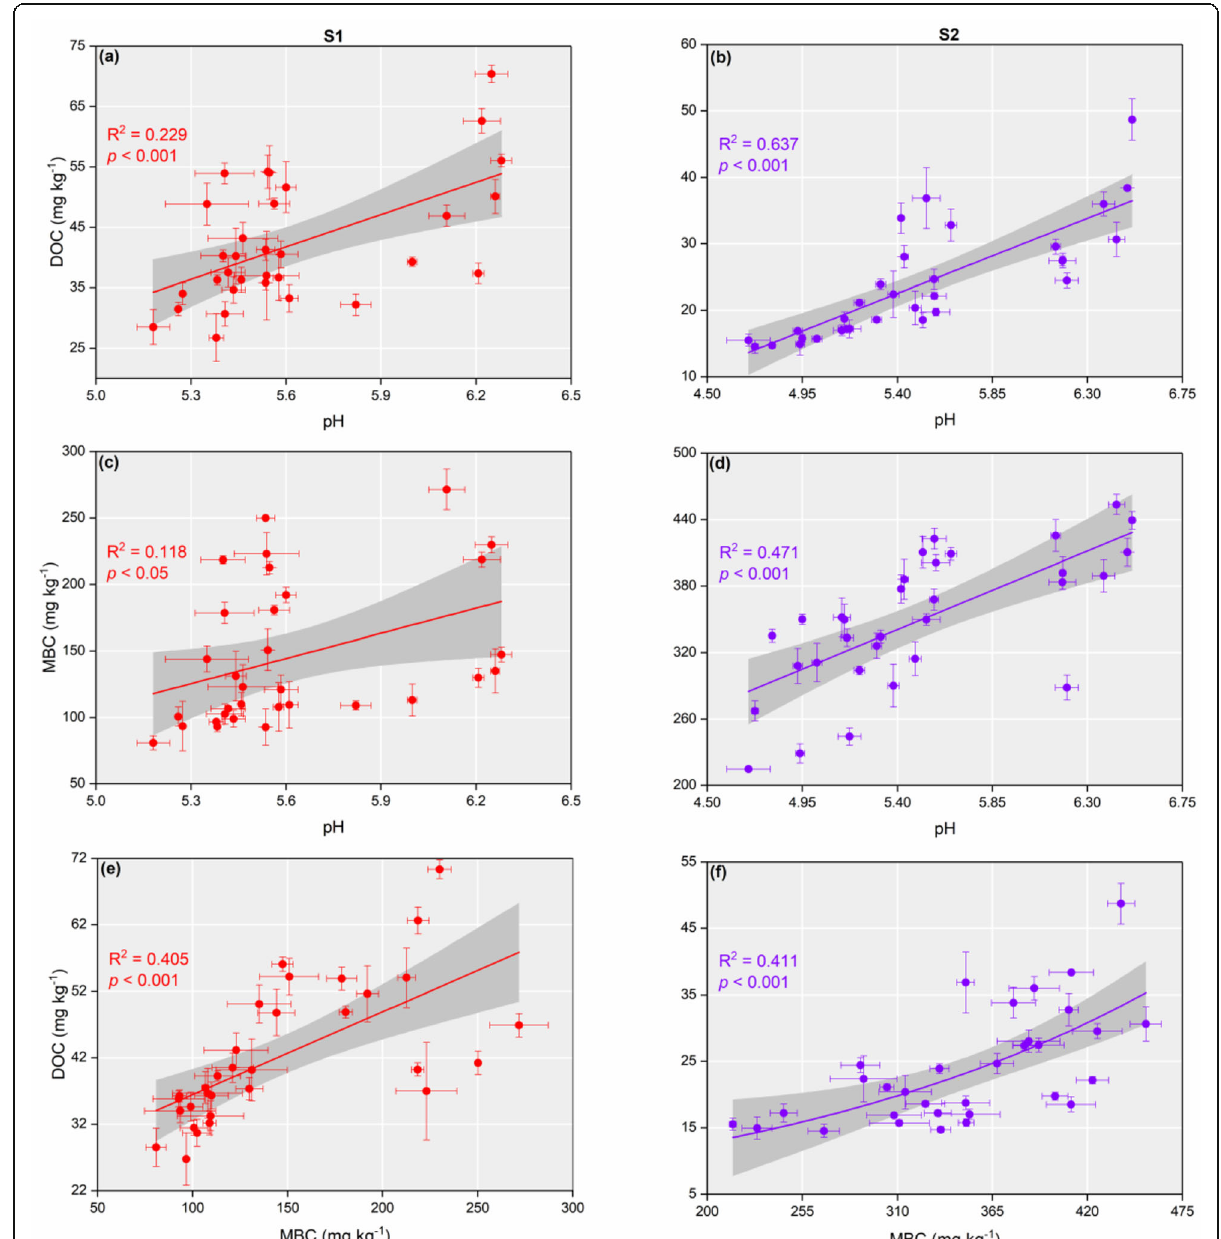
Fig. 4 Relationships among soil pH, dissolved organic carbon (DOC), and microbial biomass carbon (MBC) in S1 ( a , c , e ) and S2 ( b , d , f ). Shaded bands represent 95% pointwise confidence intervals. Error bars represent standard deviation of the variables ( n =